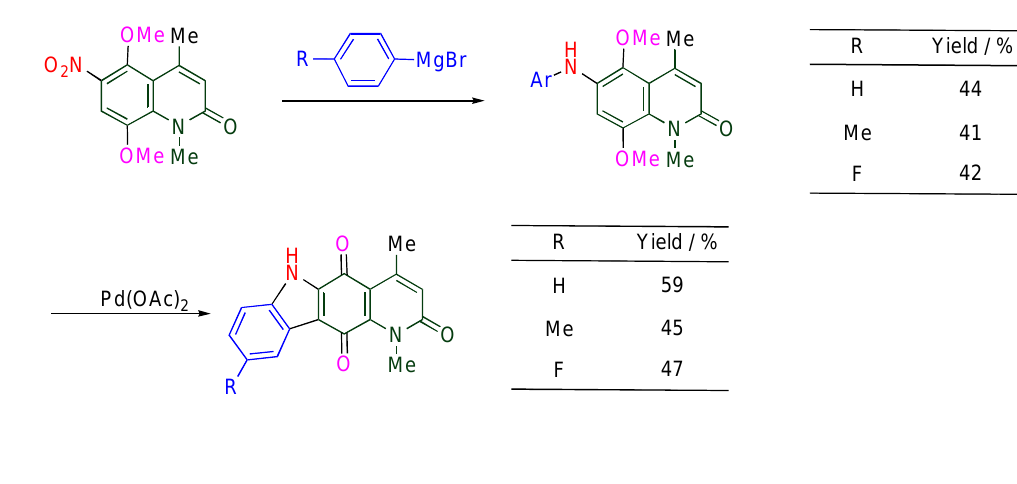
Table 3. Arylamination of the 6-nitro group followed by conversion to